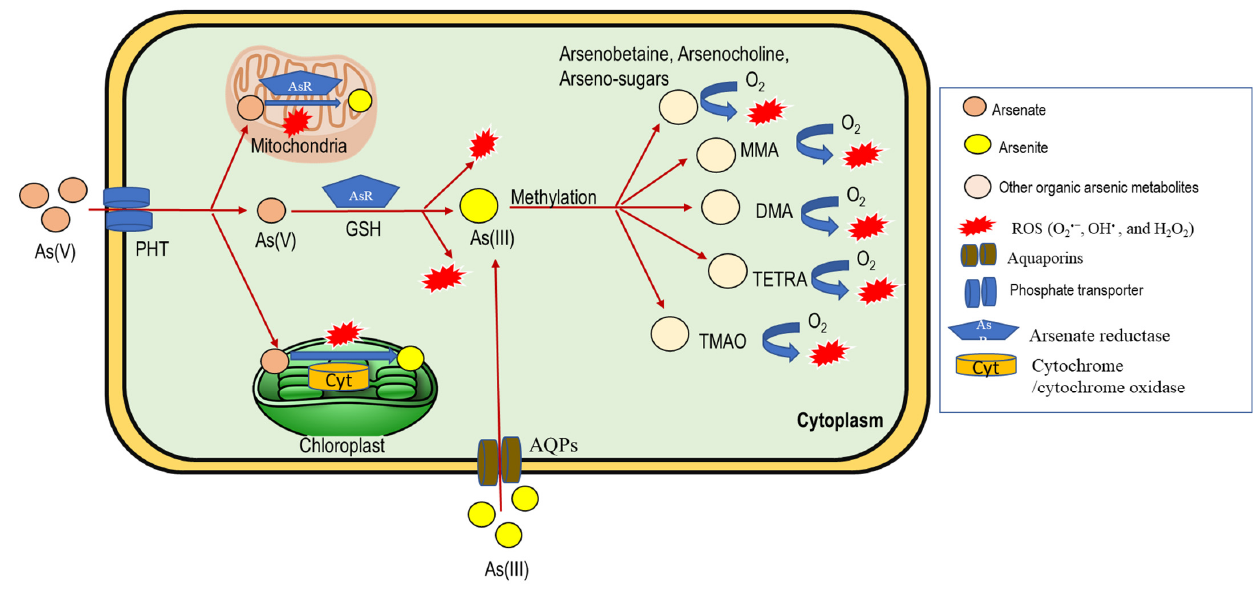
Figure 3. Schematic overview of ROS generation in plant cell under As-stress. Phosphate transporter (PHT) and aquaporins (AQPs) facilitate entry of As(V) and As(III), respectively, into the cell. Initial ROS burst occurs due to arsenate reductase (AsR) mediated and non-enzymatic transformation of As(V) into As(III) in cytoplasm, chloroplast and mitochondria. Subsequently, a second sequential ROS burst occurs due to methylation of As (III) into other organic arsenic metabolites viz. monomethylarsinic acid (MMA), dimethylarsinic acid (DMA), tetraethyalarsonium ion oxide (TETRA), trimethylarsonium oxide (TMAO), arsenobetaine, arsenochlorine and arsenosugars. Lipid peroxidation, a common toxic effect of As induced ROS, also observed in hy- peraccumulating P. vittata [13], hampered cellular and membrane functions [81]. Lipid